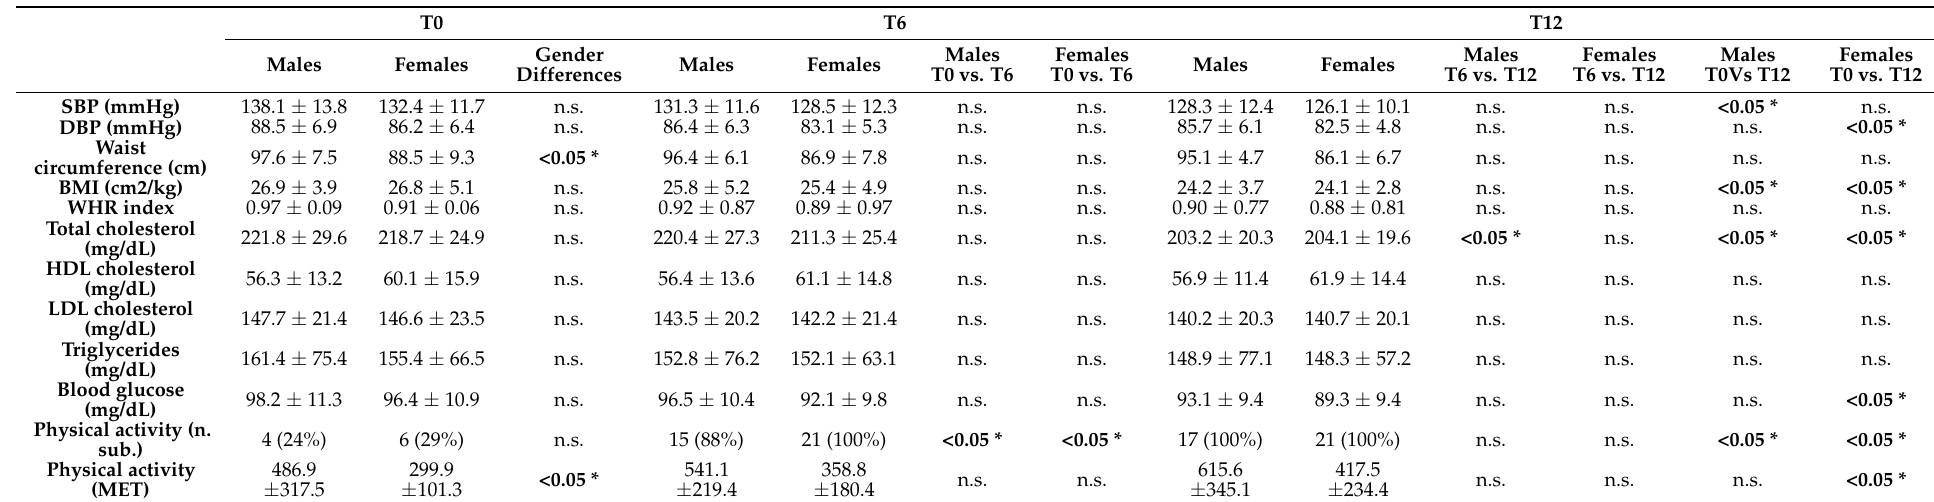
Table 2. Data obtained at T0, after 6 months (T6), and T12, broken down by gender. T6 T12 Females Gender Differences Males Females Males T0 vs. T6 Females T0 vs. T6 Males Females Males T6 vs. T12 Females T6 vs. T12 Males T0Vs T12 Females T0 vs.